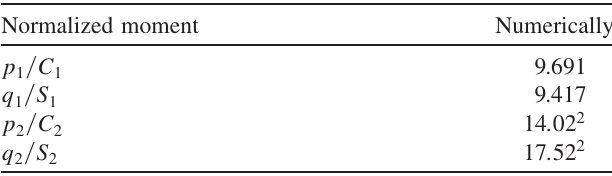
and C , q and S of the nu- 1 1 1 1